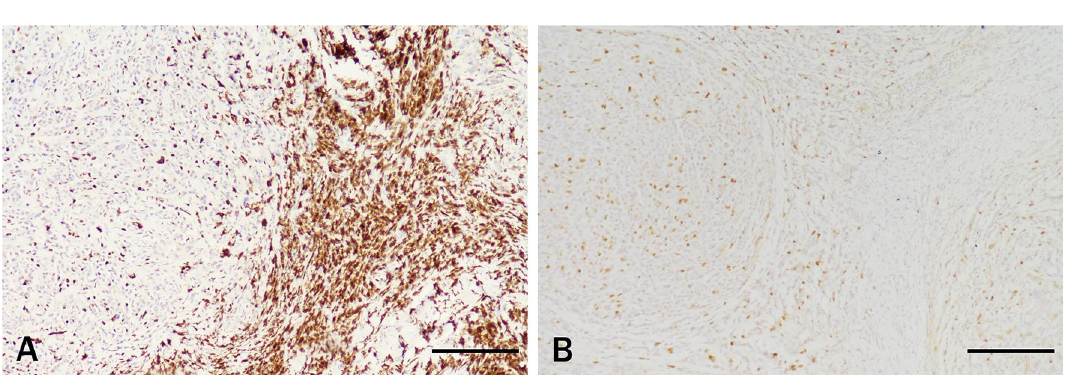
Figure 6. EBER positive tissue. ( A ) EBER-ISH staining without melanin bleaching. ( B ) was treated with 8% TCCA. Scale bar means 100